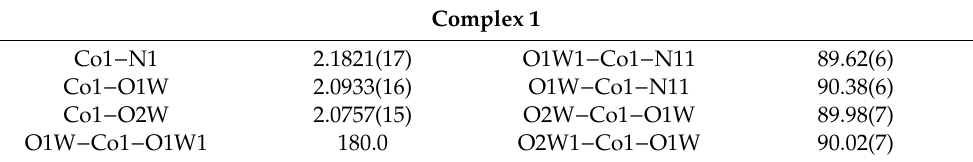
Figure 1. ( a ) Coordination environment of Co(II) atom in complex 1 , ( b ) π ··· π stacking interactions between the adjacent benzene rings, ( c ) intermolecular H bonds for complex 1 , ( d ) supramolecular framework of complex 1 formed by H bonds and π ··· π interactions (viewed along a axis). Table 2. Selected bond lengths (Å) and angles (°) for complex 1 .